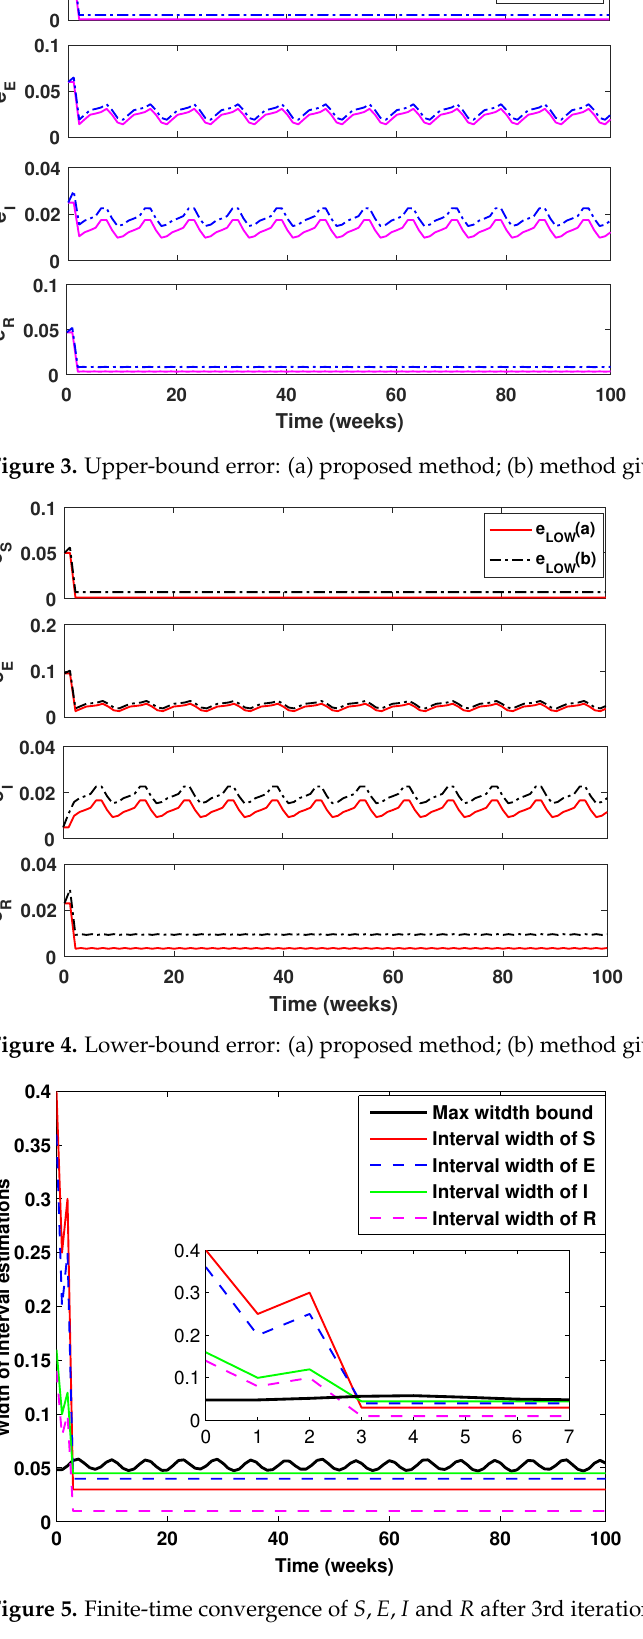
Figure 5. Finite-time convergence of S , E , I and R after 3rd